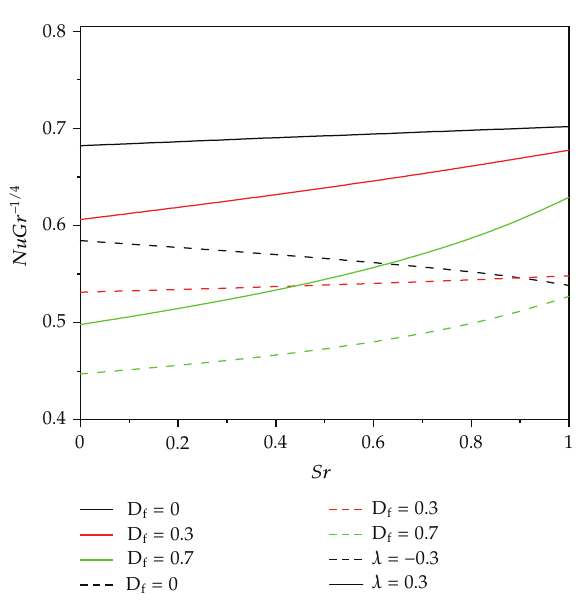
Figure 7: Variation of NuGr − 1 / 4 with Sr for di ff erent values of D f .